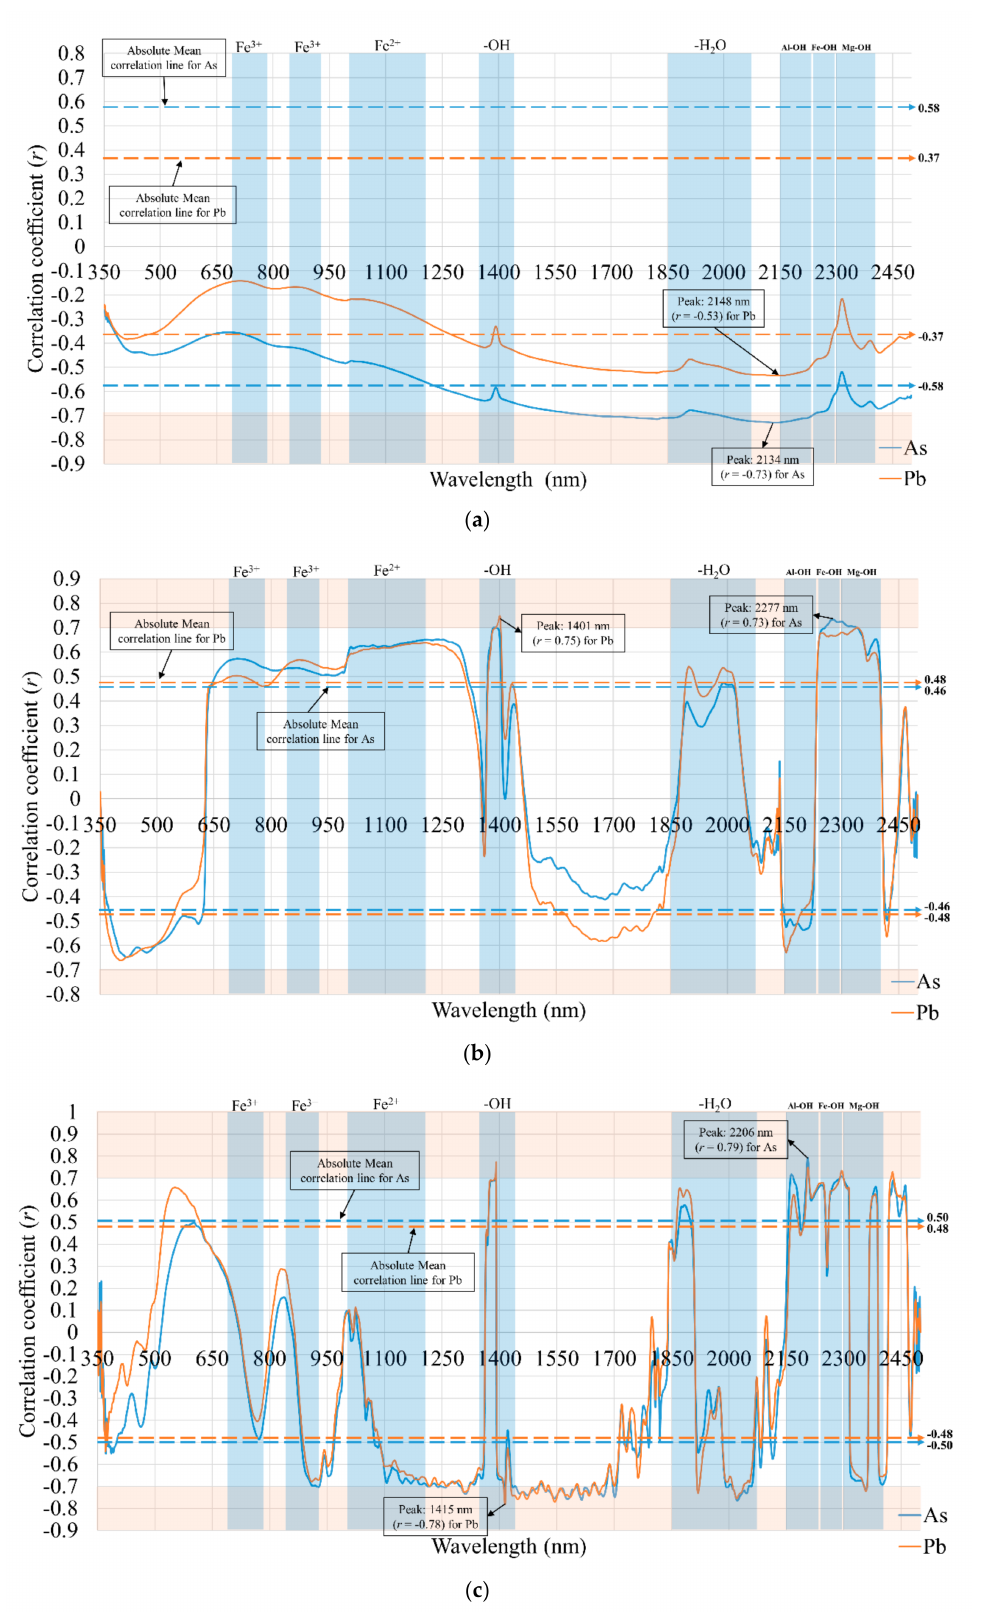
Figure 6. Correlograms between As/Pb concentrations and ( a ) raw reflectance, ( b ) continuum-removed reflectance, and the ( c ) first derivative reflectance where a correlation coefficient larger | r | > 0.7 is highlighted by color blocks. Each dashed arrow line indicates an absolute mean correlation coefficient